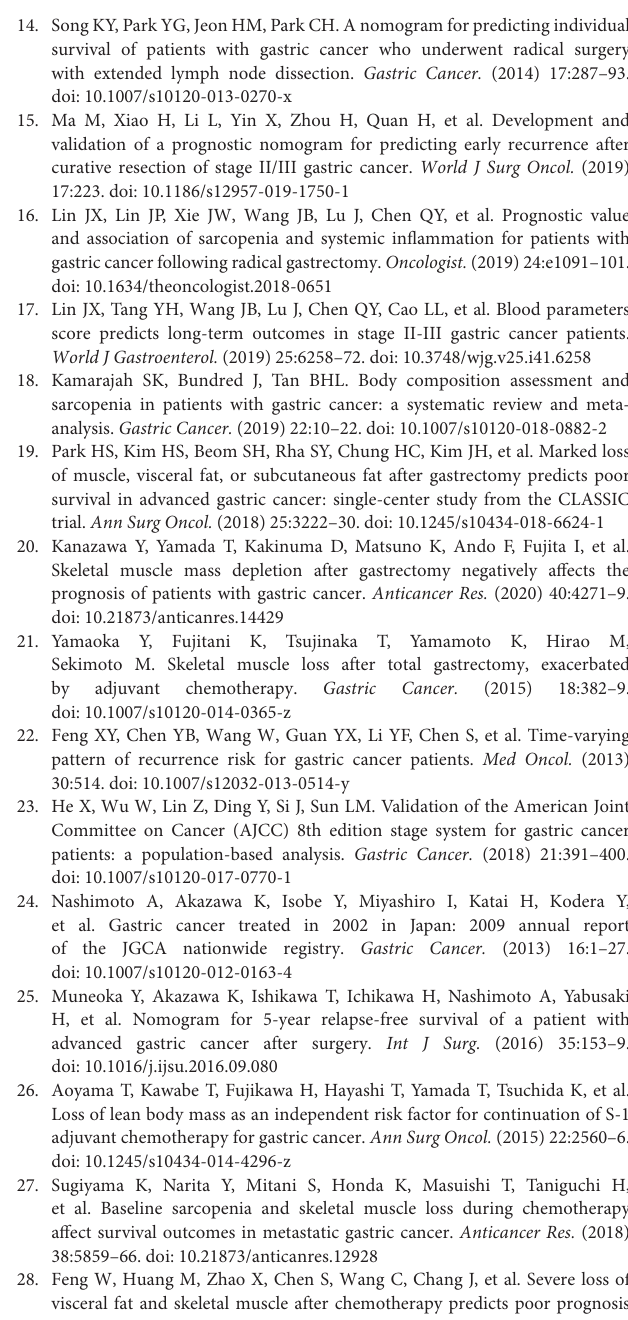
Supplementary Figure 1 | The body composition analysis were segmented using standard Hounsfield unit (HU) and different color (skeletal muscle − 29 to 150: red, SAT − 190 to − 30: yellow, and VAT − 150 to − 50: